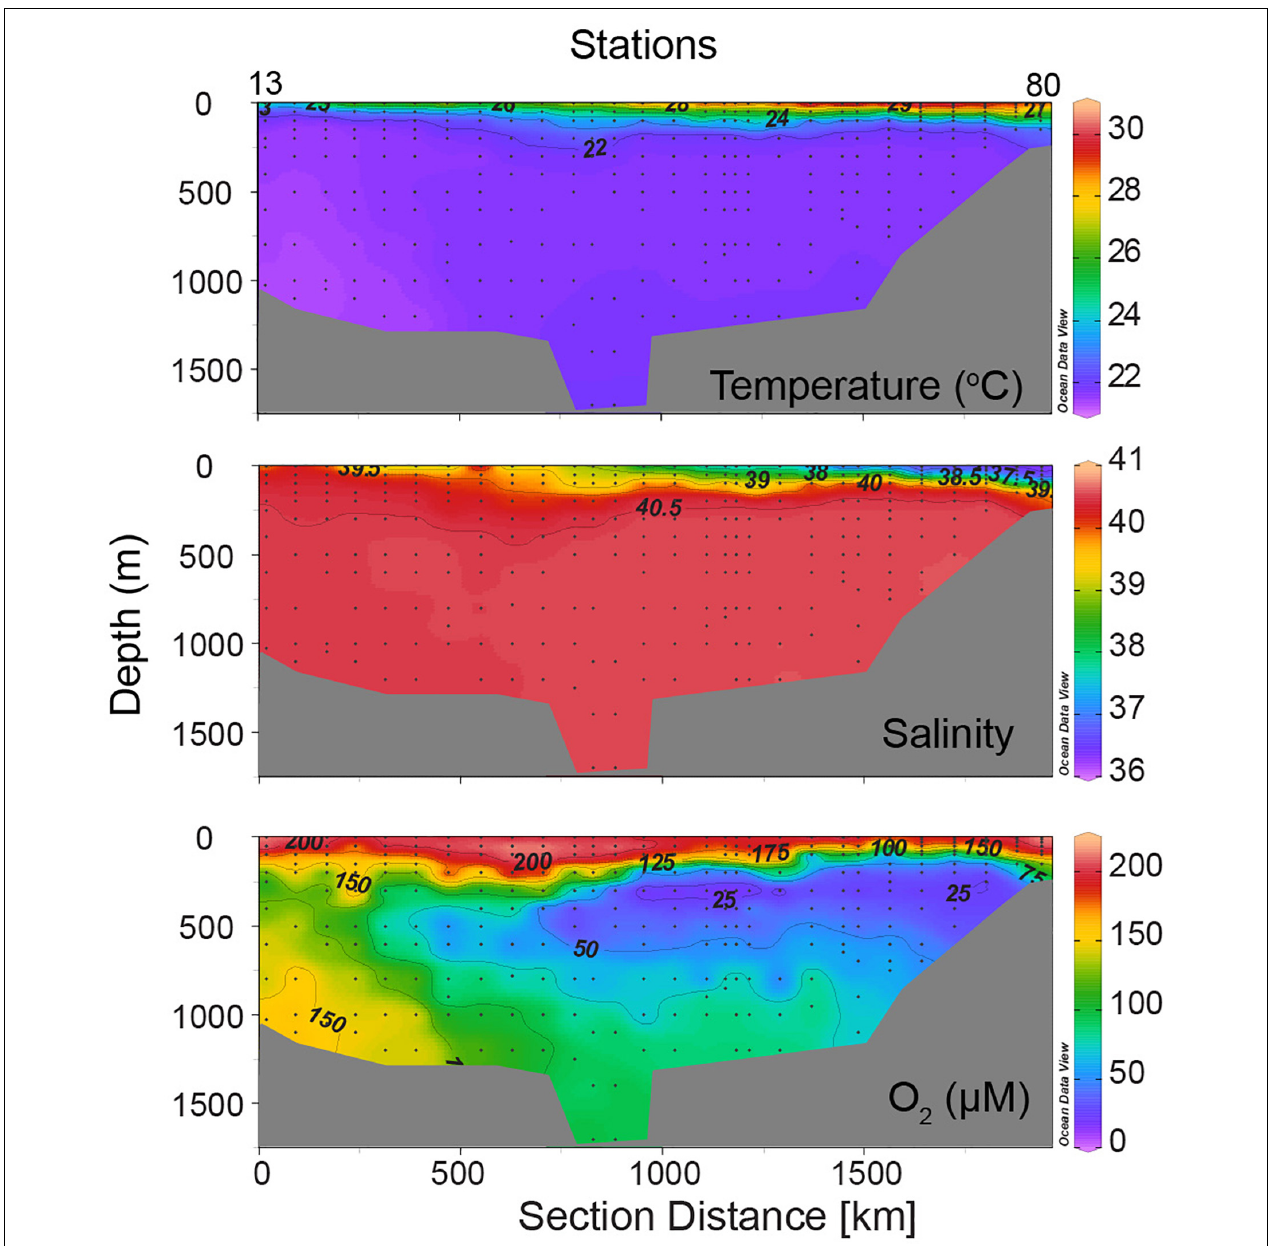
FIGURE 2 | Vertical sections of temperature, salinity, and dissolved oxygen along the axial trough of the Red Sea (data collected by the author during the Third Test-Trial Cruise of R.V. Sagar Kanya in May